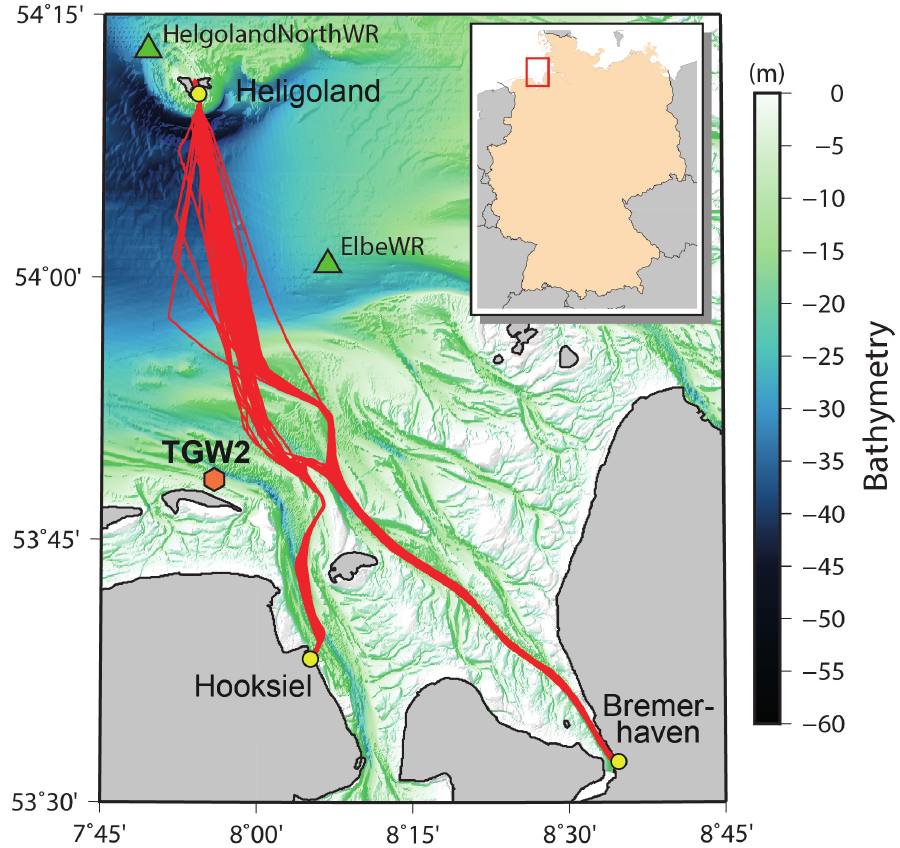
Figure 4. Overview of the investigation area. The orange hexagon highlights the position of the tide gauge station TGW2 and therefore the location of the static experiment. Ferry crossings are shown as red lines. Green triangles mark the positions of the wave